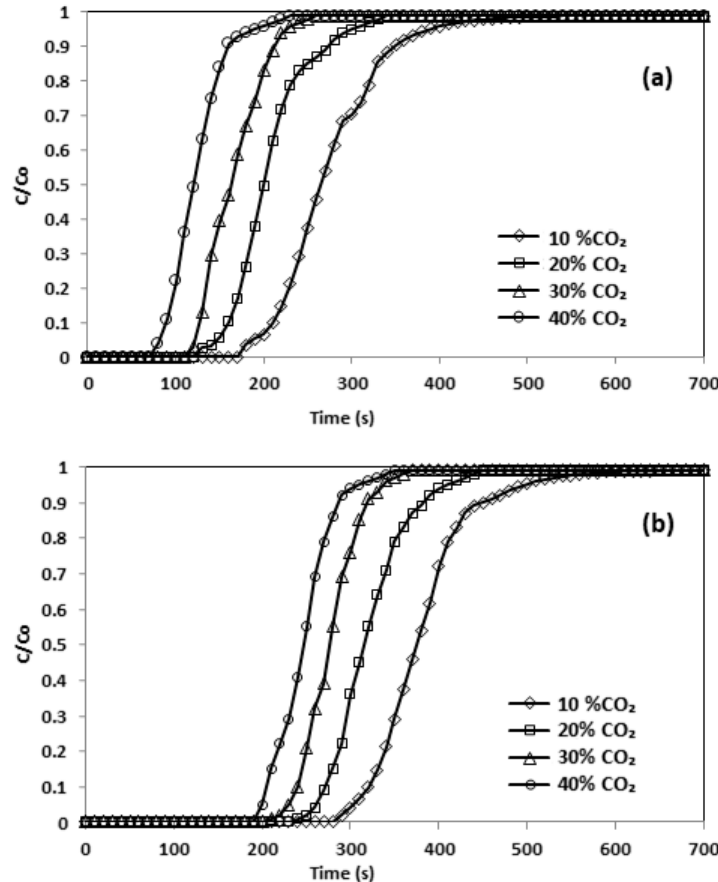
Figure 12. Breakthrough curve and effect of initial concentration ( a ) CNFCM and ( b ) modified CNFCM in constant T = 30 ° C, P = 1 bar and Flow = 50 mL/min.